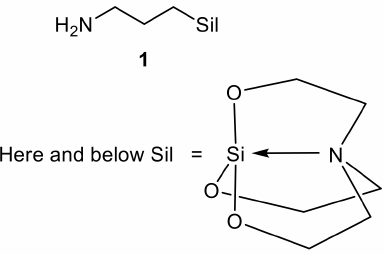
Figure 2. Chemical structures of 3-Aminopropylsilatrane (APS) ( 1